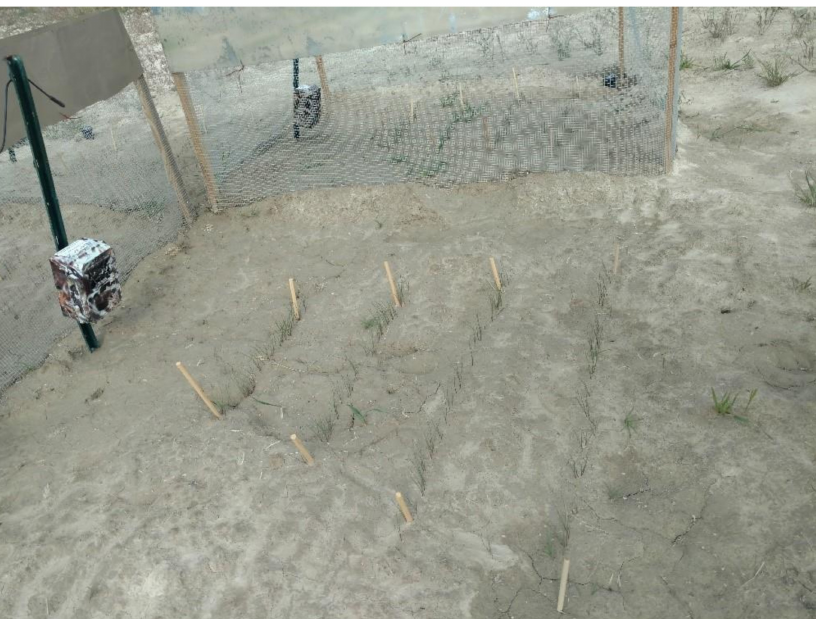
Figure 1. Photo of the plot setup with camera on left and seedlings in four rows marked by wooden dowels in the center. An unfenced plot is observed in the foreground, and a fenced plot in the background. This photograph was taken at the Murray’s Mesa site located on the Utah Test and Training Range (UTTR), Utah.